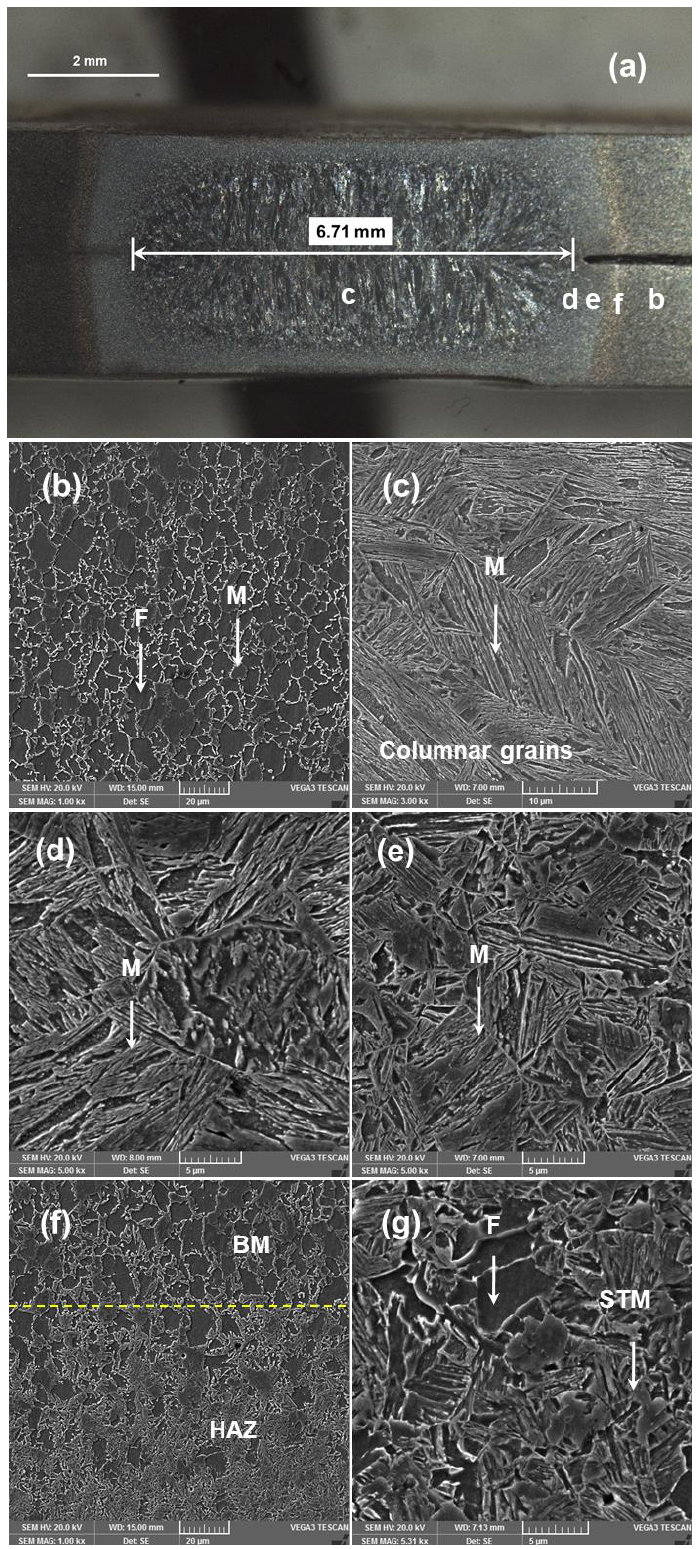
Figure 4. Microstructure evolution of SPW. ( a ) overall weld structure, ( b ) base metal (BM), ( c ) fusion zone (FZ), ( d ) coarse-grain heat-affected zone (CGHAZ), ( e ) fine-grain heat-affected zone (FGHAZ), ( f ) interface between BM and HAZ ( g ) SCHAZ (note F is ferrite, M is martensite, STM is slight tempered